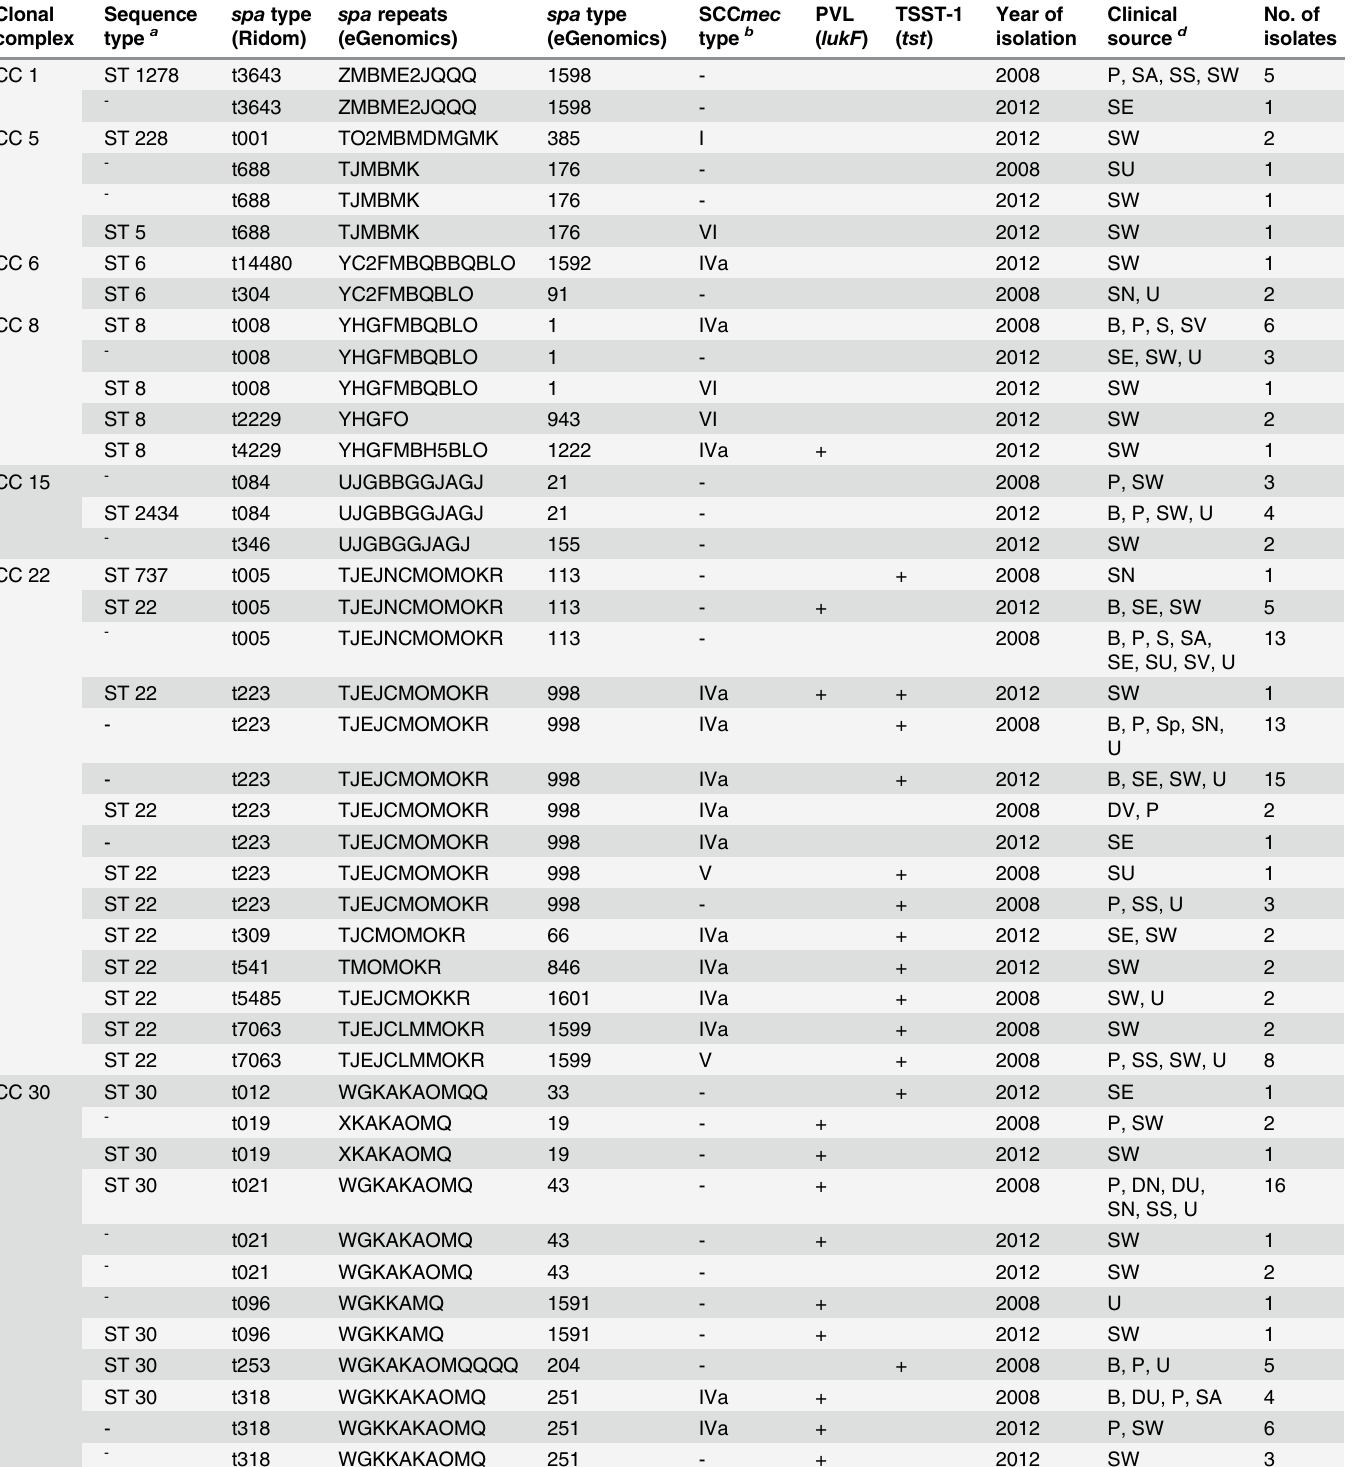
Table 1. Molecular characteristics of S . aureus isolates described in this study. Clonal